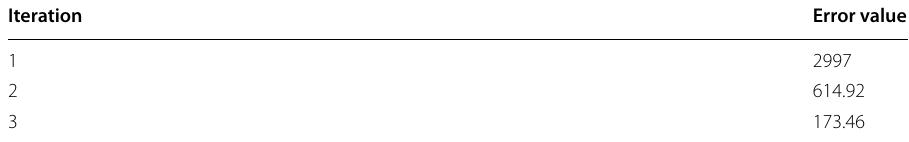
Table 13 Iteration vs error (OSI dataset) Iteration